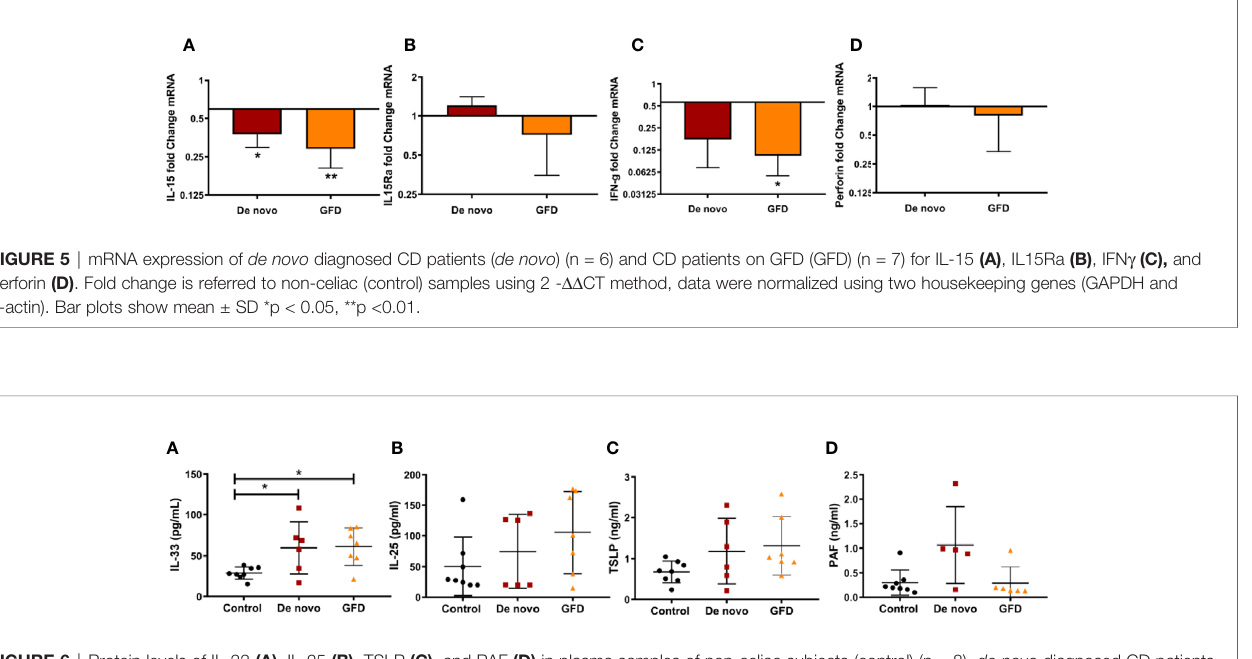
FIGURE 6 | Protein levels of IL-33 (A), IL-25 (B), TSLP (C), and PAF (D) in plasma samples of non-celiac subjects (control) (n = 8), de novo diagnosed CD patients ( de novo ) (n = 6), and CD patients on GFD (GFD) (n = 7). Scatter plots show mean ± SD. *p-value